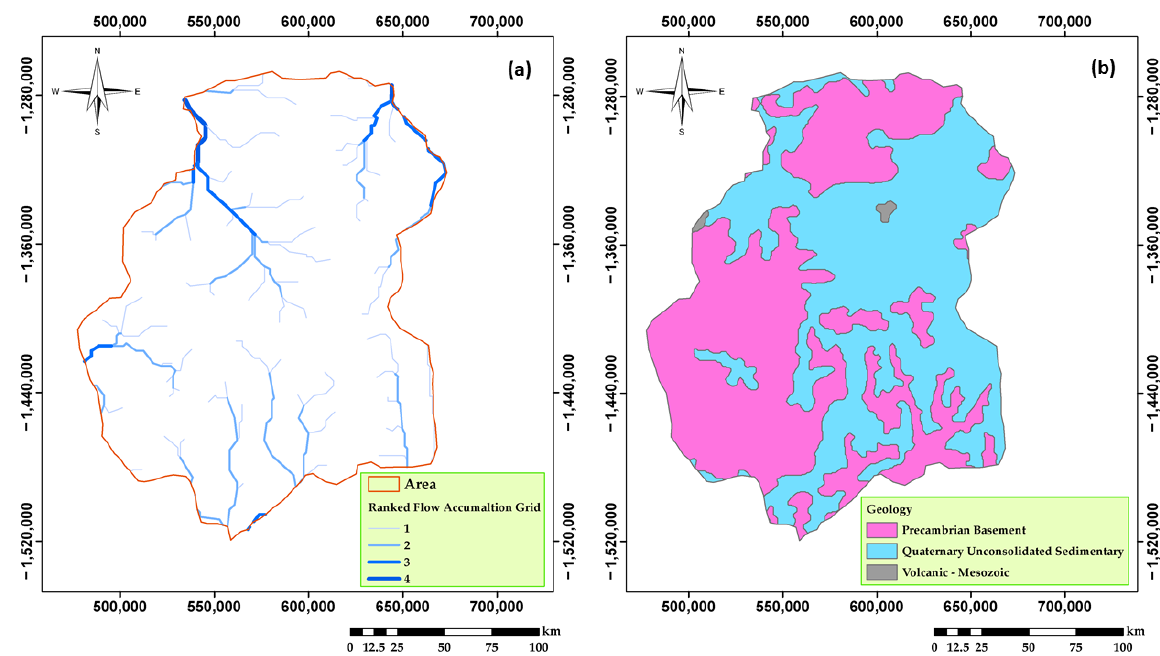
Figure 7. ( a ) Water flow accumulation and ( b ) geological features maps in the study area.